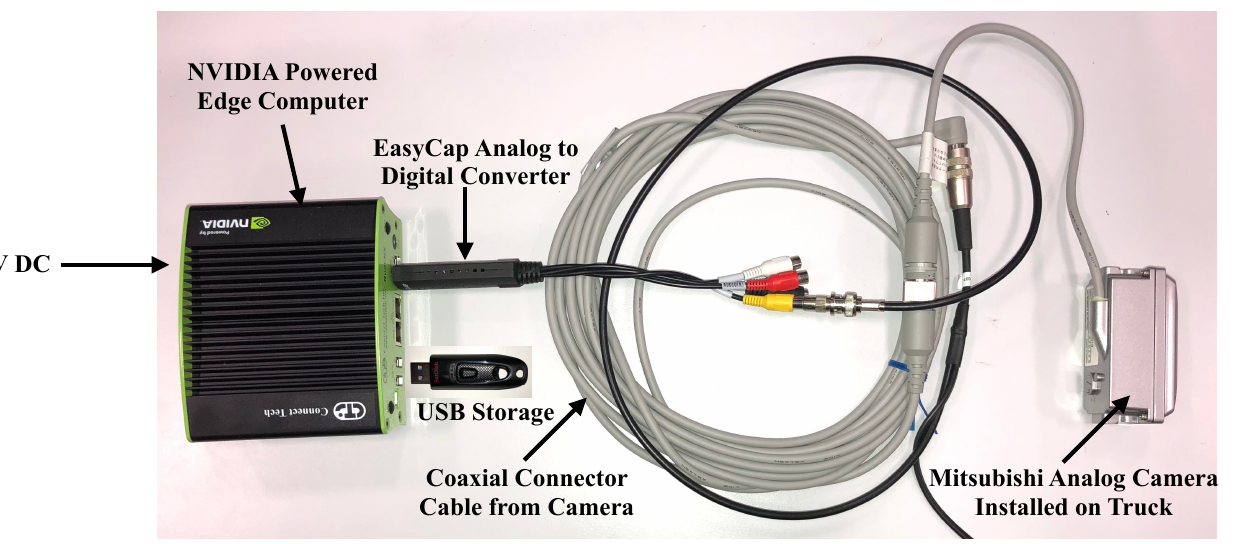
Figure 5. Laboratory hardware setup for the proposed automated plastic-bag contamina- tion